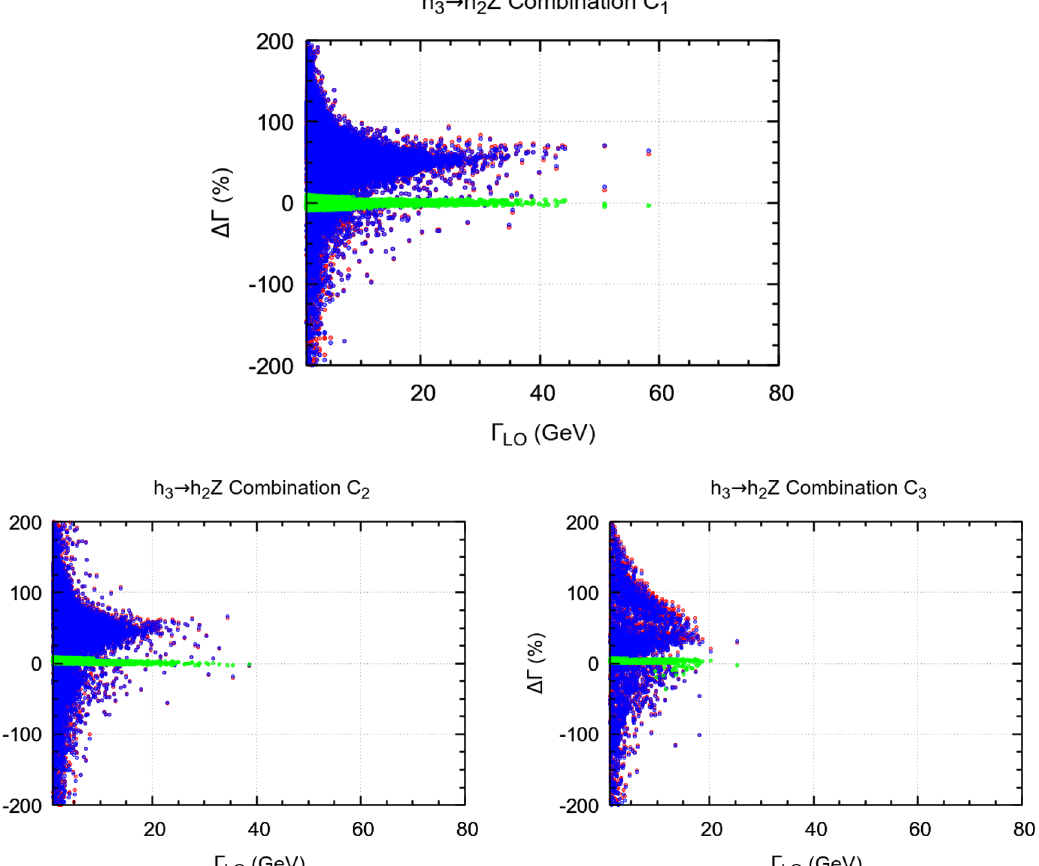
Figure 6. ∆Γ h in percentage against Γ LO , for the combinations C 1 (top), C 2 (bottom h 3 → h 2 Z 3 → h 2 Z left) and C 3 (bottom right). The cuts leading to the green points in figure 3 were applied. Only the interval 1 GeV < Γ LO < 80 GeV is shown. In red, ∆Γ h ; in green, Γ mix / Γ LO ; h 3 → h 2 Z h 3 → h 2 Z h 3 → h 2 Z 3 → h 2 Z in blue, Γ m 3 / Γ LO . According to eq. (4.5), the red points are the sum of the green and the h 3 → h 2 Z h 3 → h 2 Z blue